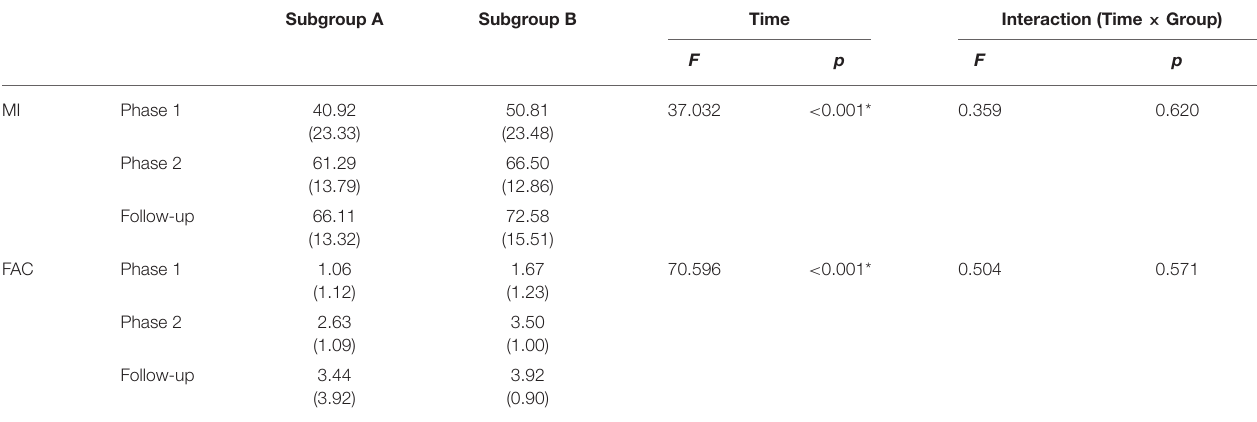
Values represent mean ( ± standard deviation). MI, motricity index; FAC, functional ambulatory category; Phase 1, start of rehabilitation; Phase 2, end of rehabilitation; Follow-up, follow-up 6 months after onset. * p <